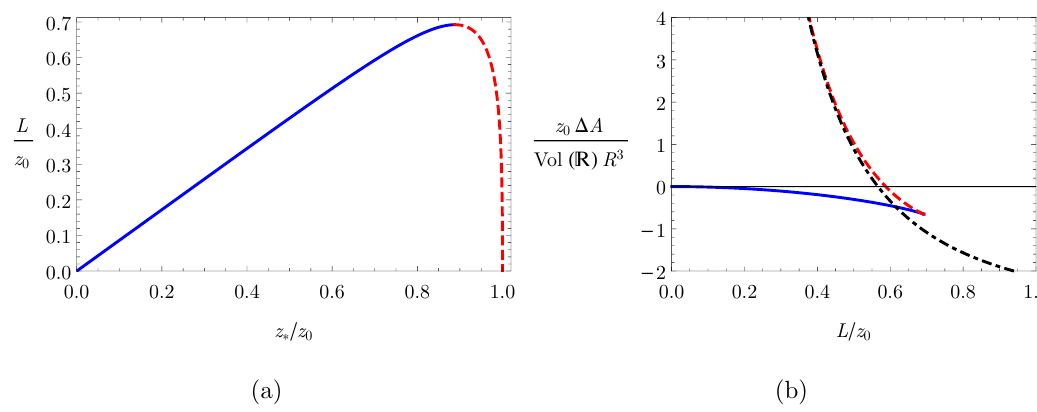
Figure 18. (a) Strip width L versus turn-around point z , both in units of z 0 , for connected (cid:3) extremal surfaces in the AdS soliton with d = 4. Two branches of connected extremal surfaces exist, with z =z 0 < 0 : 89 (blue solid) and z =z 0 > 0 : 89 (red dashed). (b) The di(cid:11)erences in area, (cid:1) A , nor- (cid:3) (cid:3) malized by Vol ( R ) R 3 =z 0 , between the two connected extremal surfaces (blue solid and red dashed) and the disconnected extremal surfaces (black dot-dashed), and the minimal surface with the same L in compacti(cid:12)ed AdS 5 , versus L=z 0 . A \(cid:12)rst-order phase transition" occurs at L=z 0 (cid:25) 0 : 615 [72] from a connected (blue solid) to a disconnected (black dot-dashed) extremal